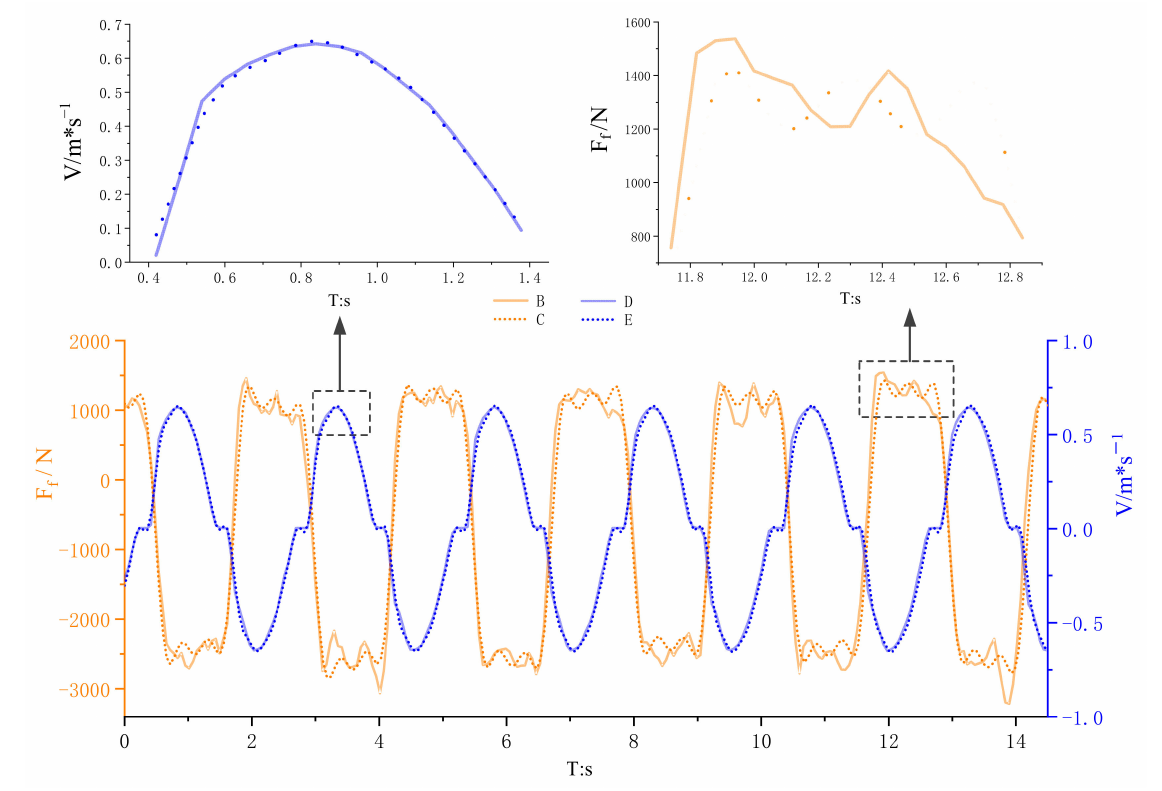
Figure 24. Friction − velocity mapping curve of hydraulic cylinder. B denotes the frictional force of the hydraulic cylinder; C denotes the hydraulic cylinder mapping friction; D denotes the hydraulic cylinder speed; E denotes the hydraulic cylinder mapping